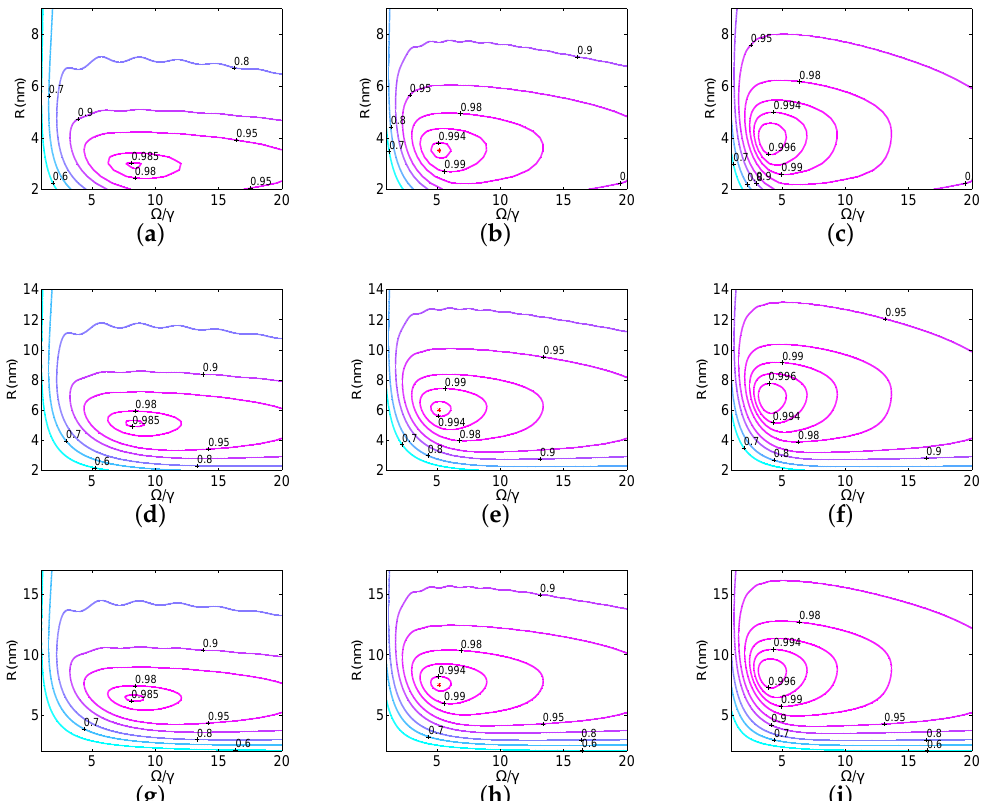
Figure 3. Contours of ρ 22 ( T ) as functions of the distance R between the QD and the monolayer and the Rabi frequency Ω , for the three MoS 2 qualities (three rows from top to bottom corresponding to good, medium, and bad) and different durations, ( a , d , g ) T = 1/ γ = 0.548 ns, ( b , e , h ) T = 2/ γ = 1.097 ns, and ( c , f , i ) T = 3/ γ = 1.645 ns.